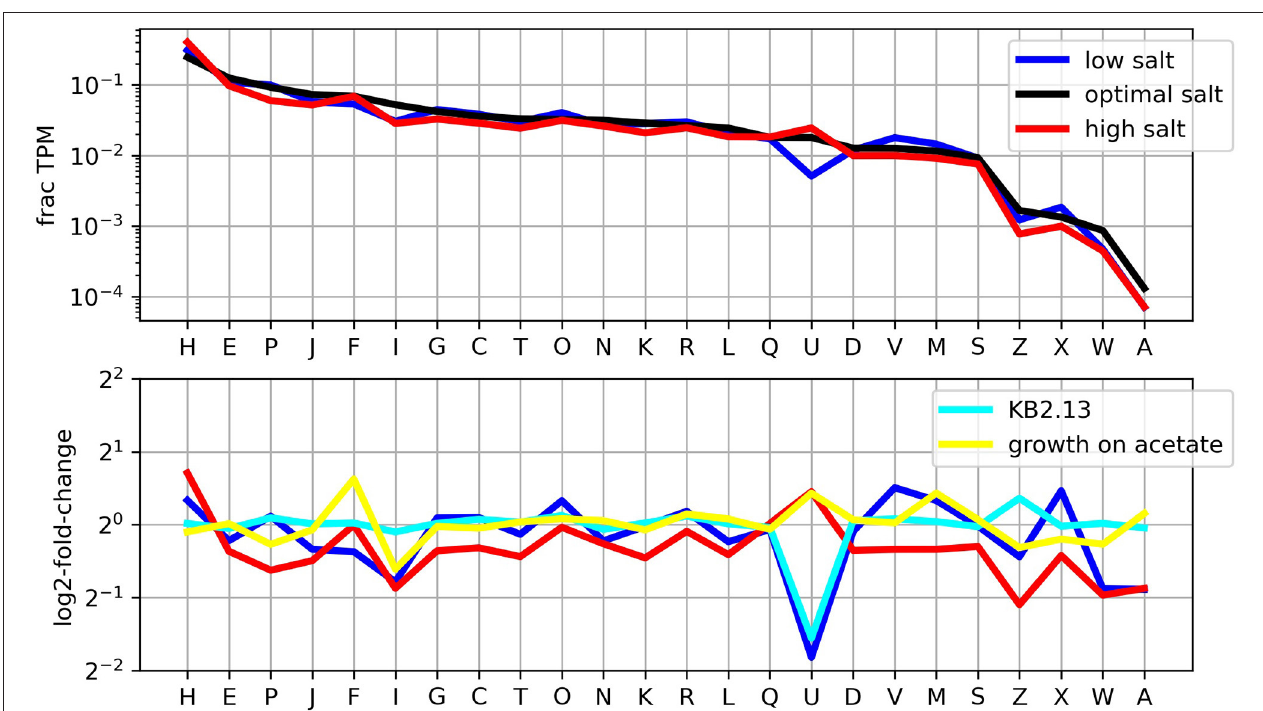
FIGURE 3 | Distribution of transcription levels by COG classes. The upper panel shows the fraction of the transcriptome in TPM that corresponds to each COG class. The lower panel shows the (log) ratios of the frequencies for each condition compared to growth on glucose at optimal salt concentration.